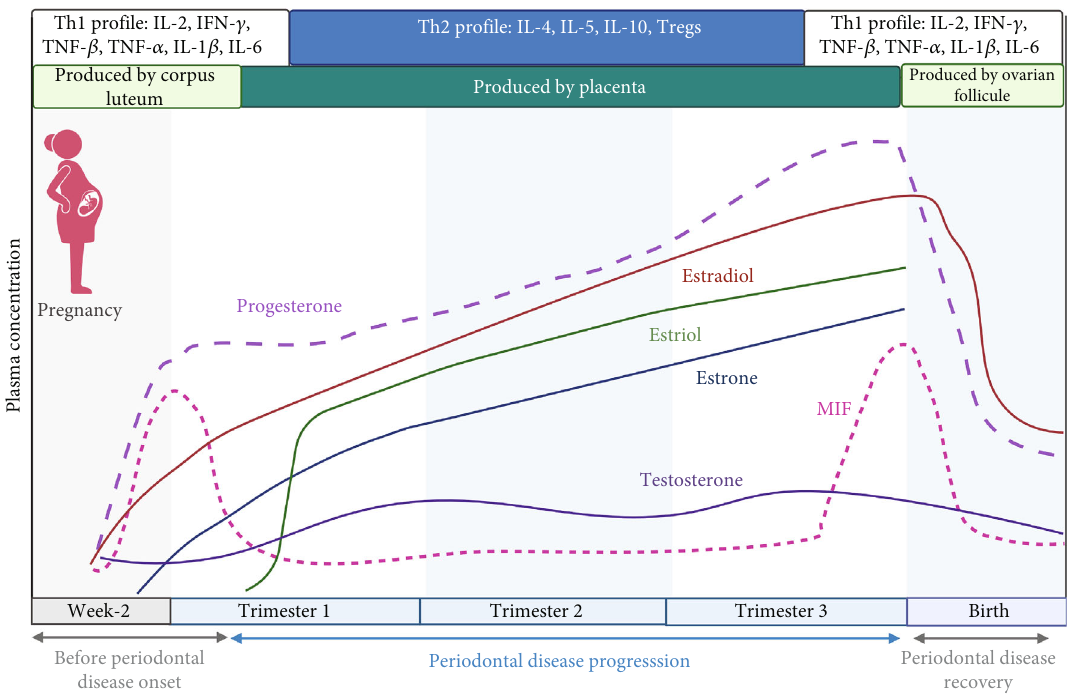
Figure 2: Time course of pregnancy hormones, periodontal disease, and the proin fl ammatory cytokine MIF. During early gestation, hormones are produced in the corpus luteum, and later until the end of gestation, they are produced in the placenta. Estriol is also synthesized in the placenta, and its production ceases when the pregnancy reaches term. Therefore, embryo implantation and early gestation require a Th1 pro fi le with the expression of proin fl ammatory cytokines. During the second half of gestation, the expression of these cytokines decreases, and the pro fi le is a Th2 and Treg cell pro fi le, which is maintained until delivery, when the pro fi le returns to a Th1 pro fi le. The expression of MIF, which is a proin fl ammatory cytokine, maintains this trend during pregnancy. Created with BioRender.com